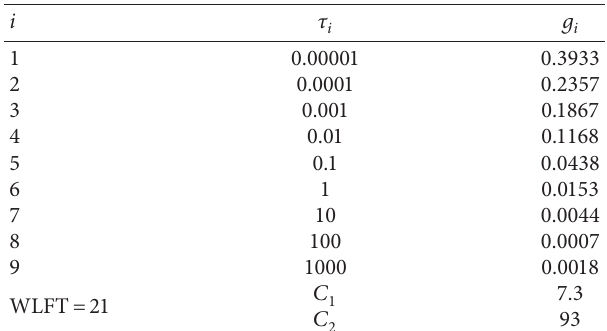
Table 4: Viscoelastic parameters of asphalt material at 21 ° C [31].